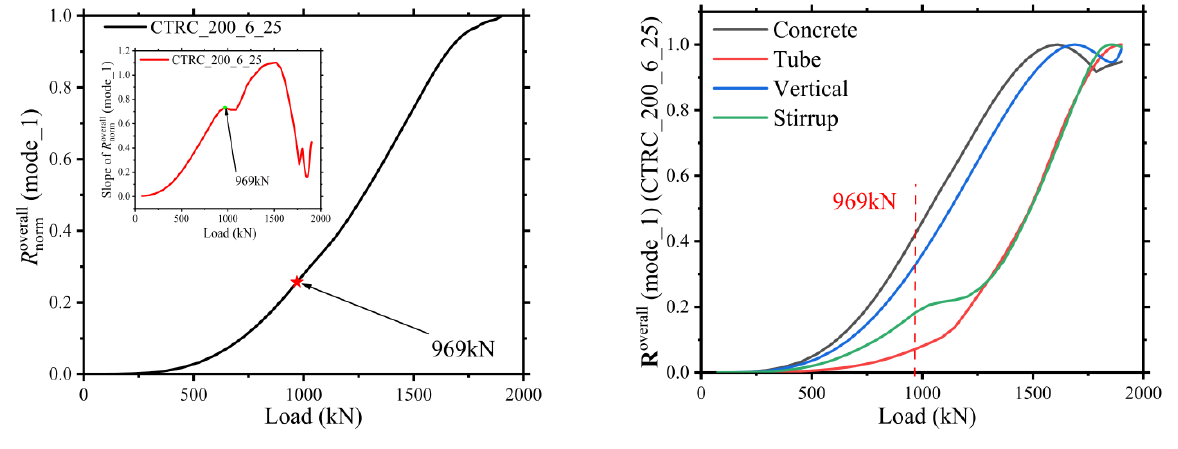
Figure 5. Overall characteristic pairs of CTRC_200_6_25.